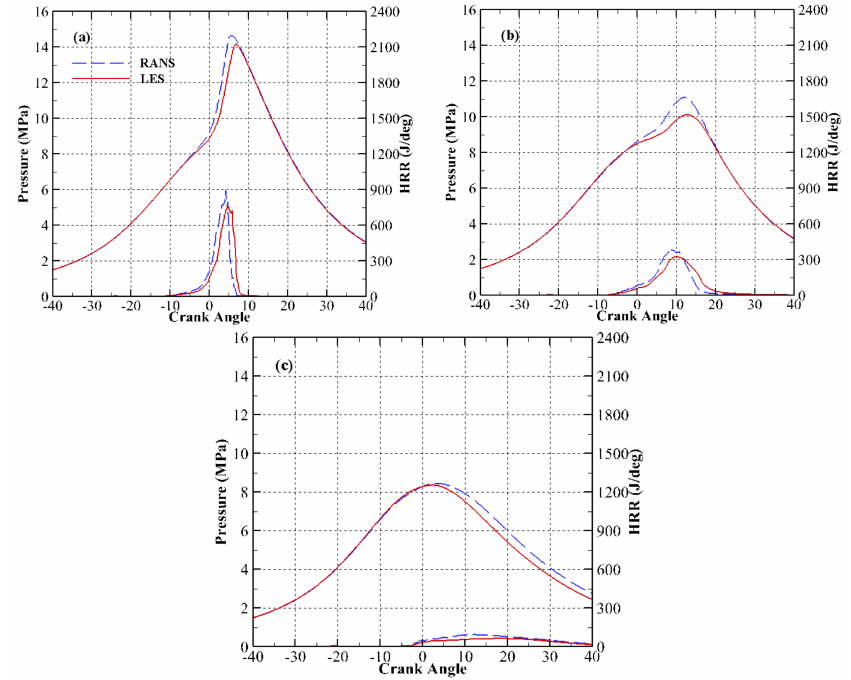
Figure 12. Comparison of LES and RANS model for cylinder pressure and heat release rate (HRR) variation with engine speed sweep: ( a ) 800 rpm; ( b ) 1300 rpm; ( c ) 1800